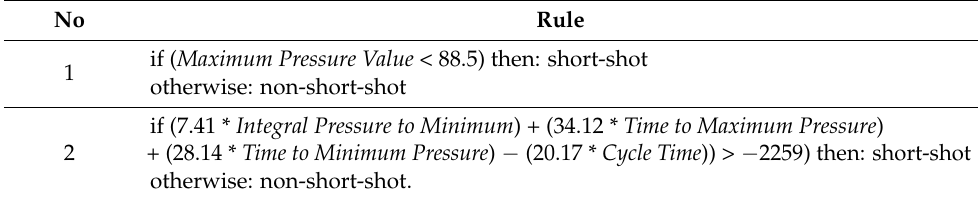
Table 7. Two rules were constructed from the selected injection molding parameters.